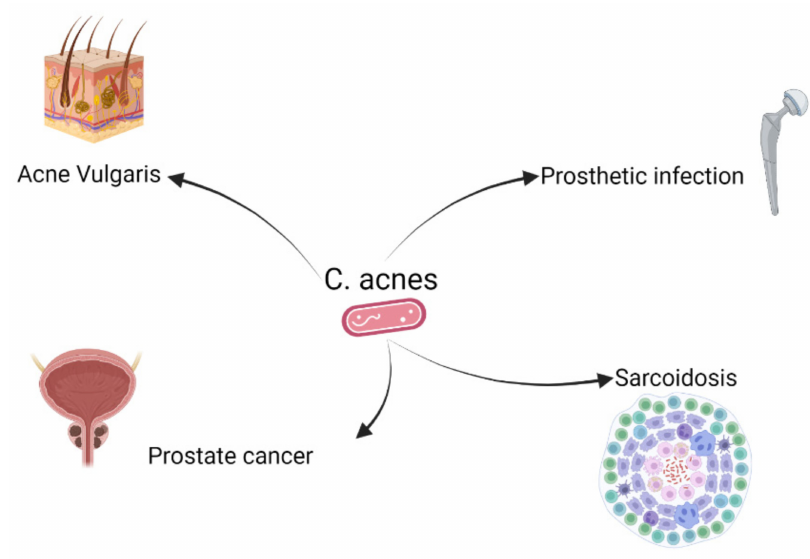
Figure 1. Known and suspected disorders associated with Cutibacterium acnes. There is convincing scientific evidence that C. acnes is involved in the development of acne vulgaris and prosthetic infections. Furthermore, associations have been found between the occurrence of prostate cancer or sarcoidosis and the presence of C. acnes , for which a causal role has not yet been